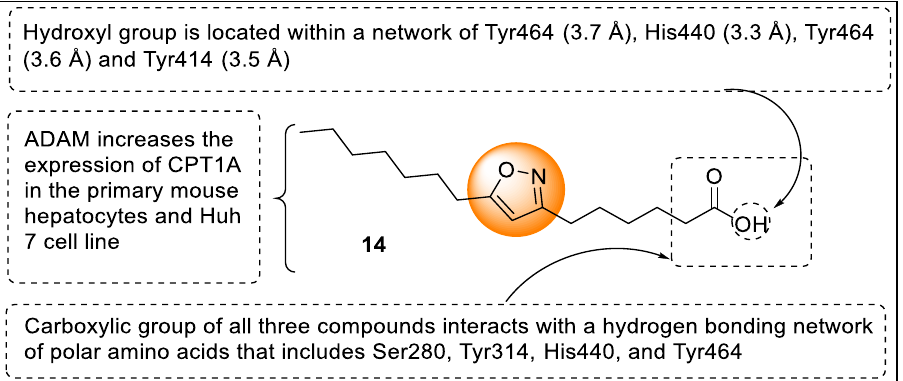
Figure 17. Structural activity relationship of oxazole hybrids ( 14 ) as potent PPAR ligands.